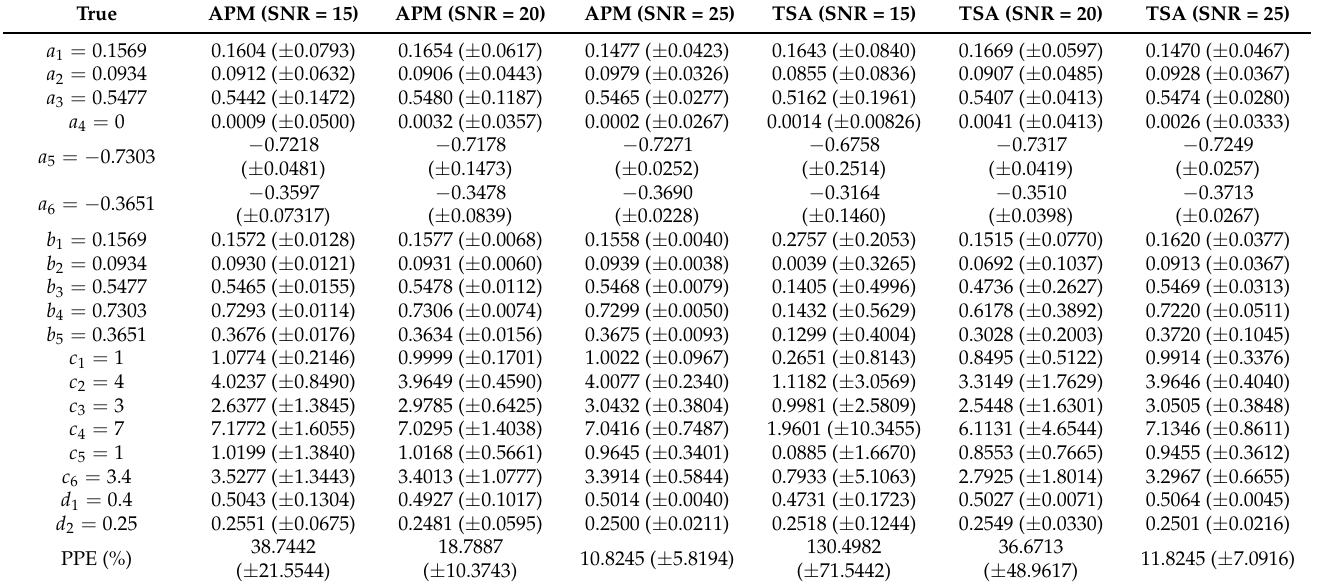
Table 1. Estimated results of θ and